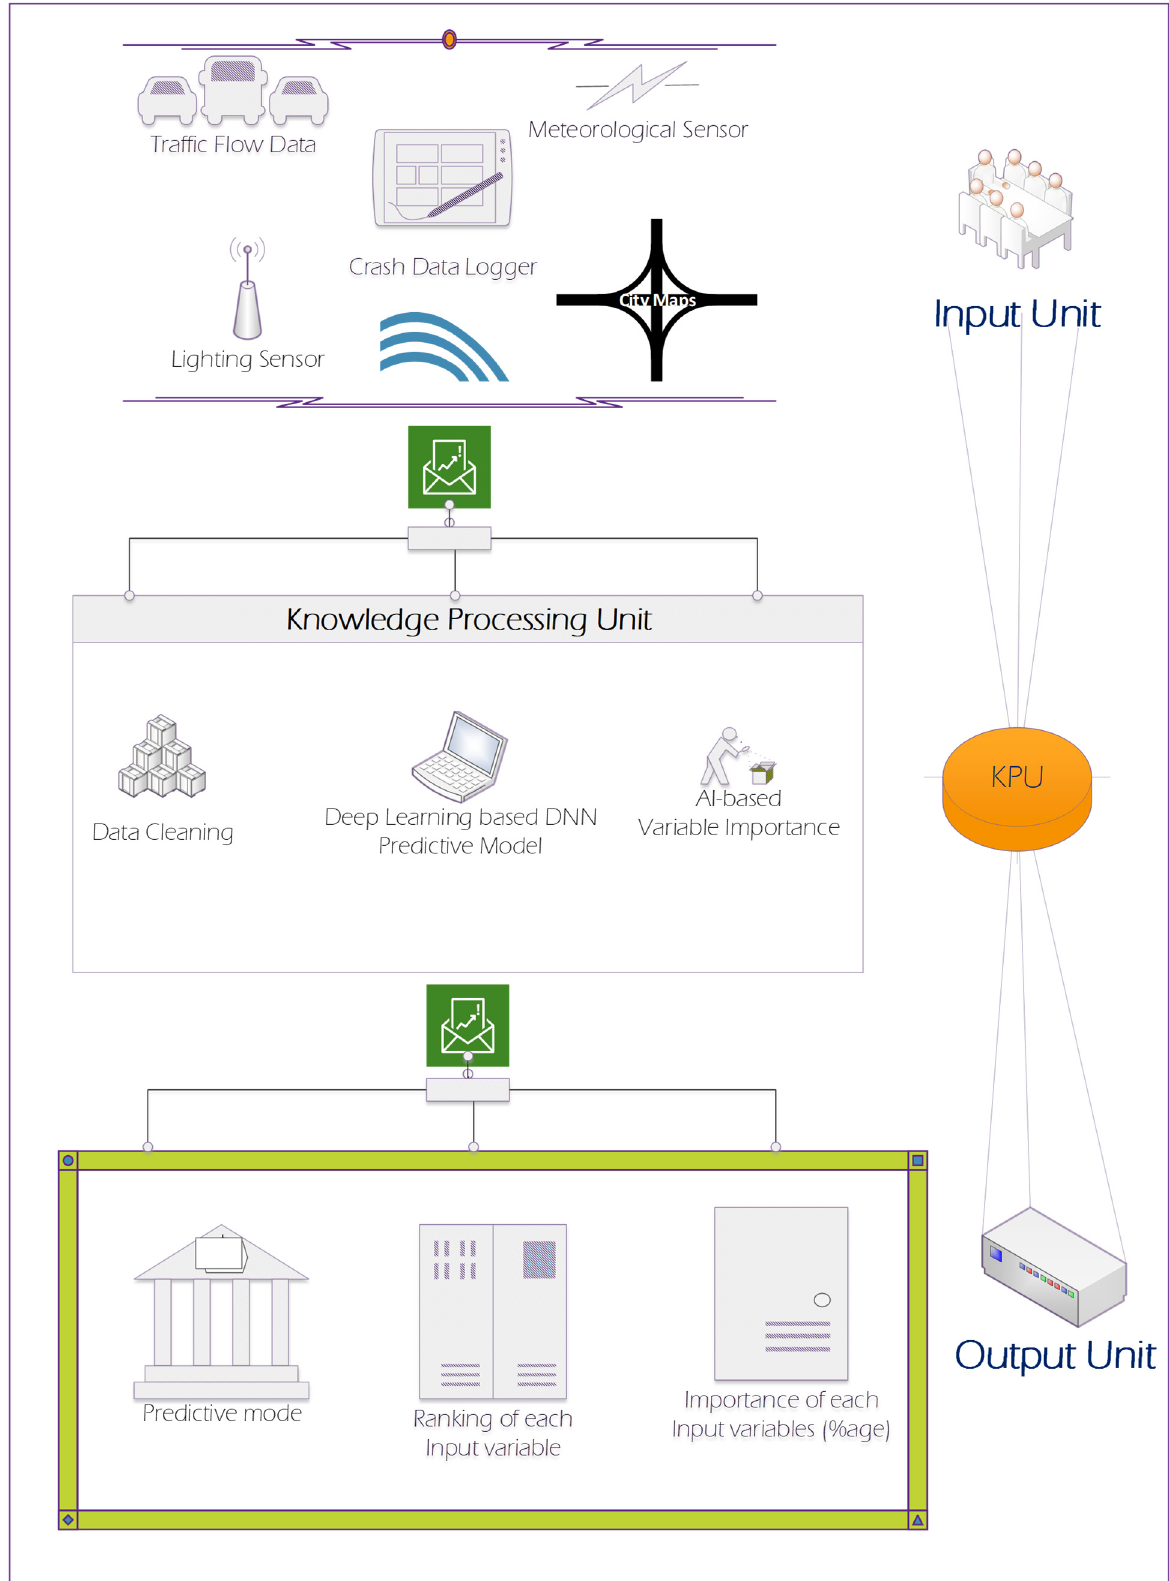
Figure 1. Real-time intelligent embedded learning system.